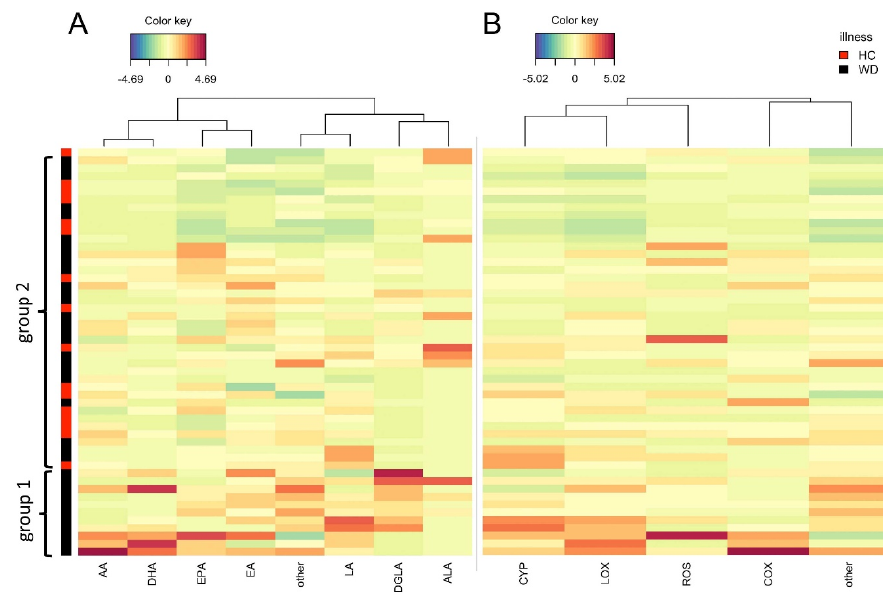
Figure 4. A clustered image map was performed using the Euclidean distance and complete linkage clustering algorithm. All polyunsaturated fatty acids (PUFA) derivatives were summed up according to their ( A ) initial substrate of biochemical pathways or ( B ) pathways’ enzyme origin. In the figure, each entry of the matrix is colored according to its value, rows represent subjects, columns represent metabolites. Dendrograms are shown on the top (for metabolites). The color bar on the left side of the picture indicates whether a subject is WD (black) or a HC (red). Abbreviations: AA: arachidonic acid; DHA: docosahexaenoic acid, EPA: eicosapentaenoic acid; EA: AEA and OEA; LA: linoleic acid; DGLA: dihomo-γ-linolenic acid; ALA: α-linolenic acid; CYP: cytochrome P450 monooxygenase; LOX: lipoxygenase; ROS: reactive oxygen species; COX: cyclooxygenase.